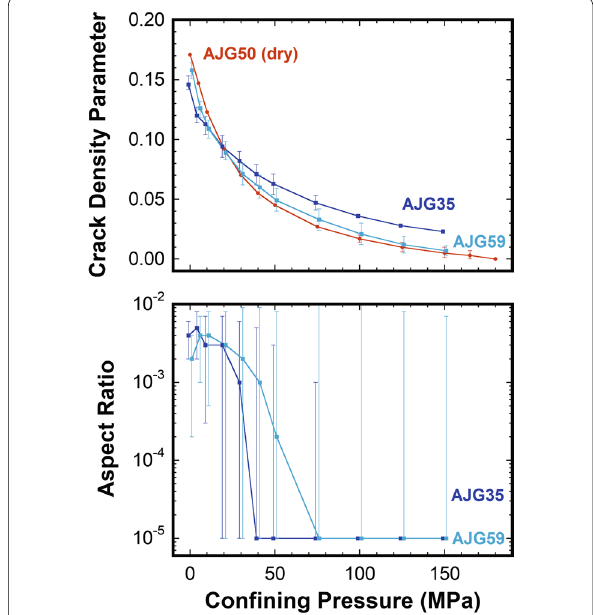
Fig. 7 Estimated crack density parameter and aspect ratio as a function of confining pressure. The crack density parameter is relatively well constrained, while aspect ratio poorly constrained, especially for aspect ratio less than 3 10 − 3 ×